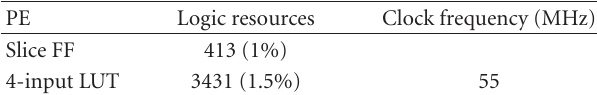
Table 3: PE performances and hardware requirements.